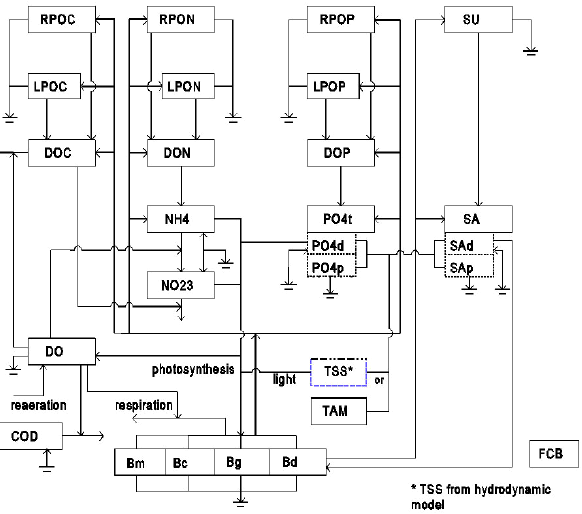
Figure 1. Schematic Diagram for The EFDC Water Column Water Quality Model (13).